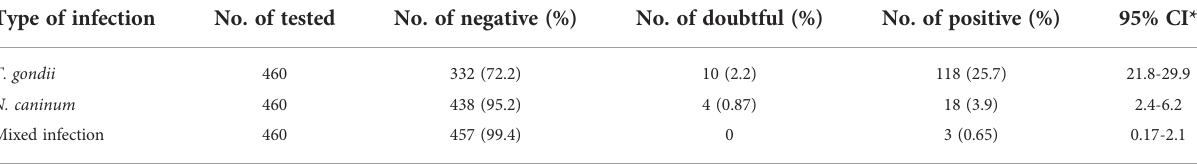
TABLE 1 Seroprevalence of Toxoplasma gondii, Neospora caninum and mixed infection in camels in Egypt. Type of infection